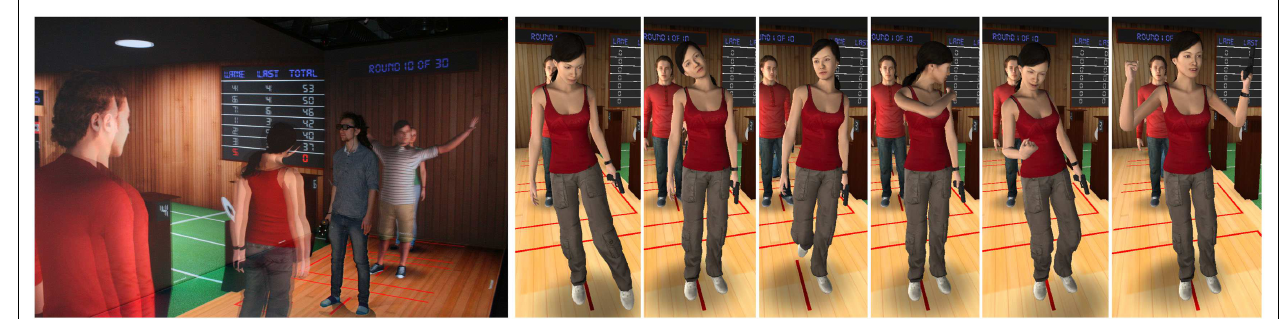
FIGURE 3 |Avatar animations . Leftmost, virtual competitors are animated according to their performance. Right, Snapshots of several of the animations played by the avatars after each round. Rightmost, animations are played for higher